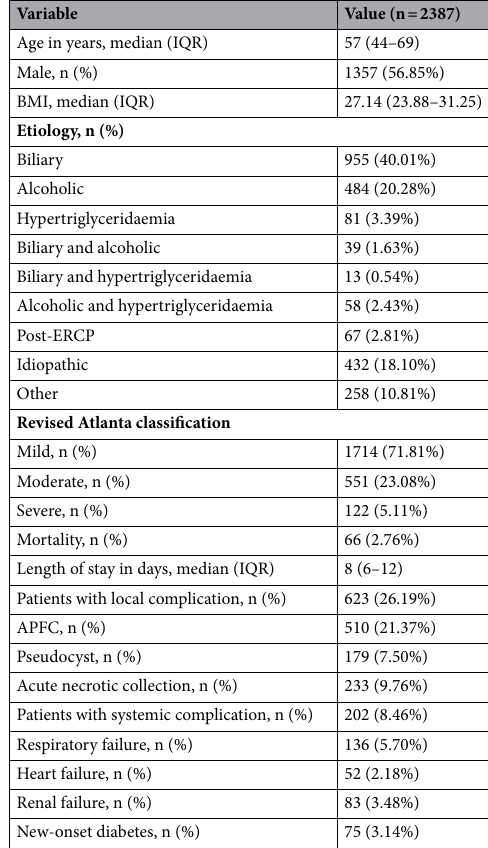
Table 1. Characteristics of the analyzed study population. APFC acute peripancreatic fluid collection, BMI body mass index, ERCP endoscopic retrograde cholangiopancreatography, IQR interquartile